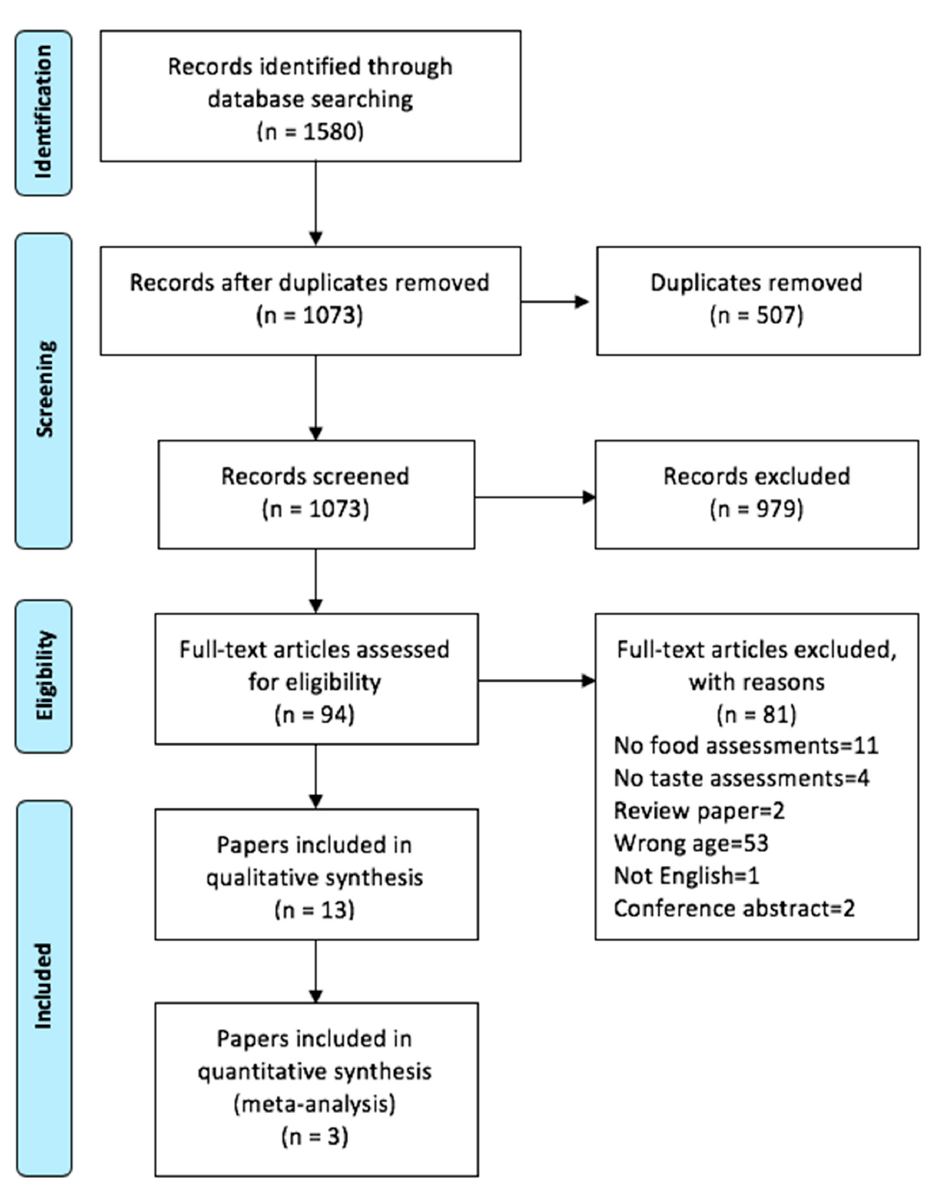
Figure 1. Flow diagram indicating number of studies.